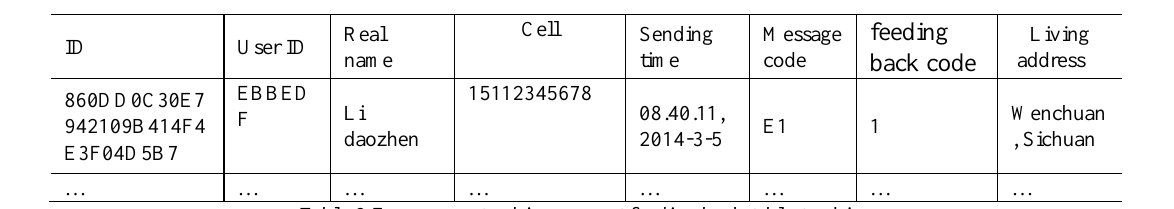
Table 3 Emergency tracking request feeding back table tracking